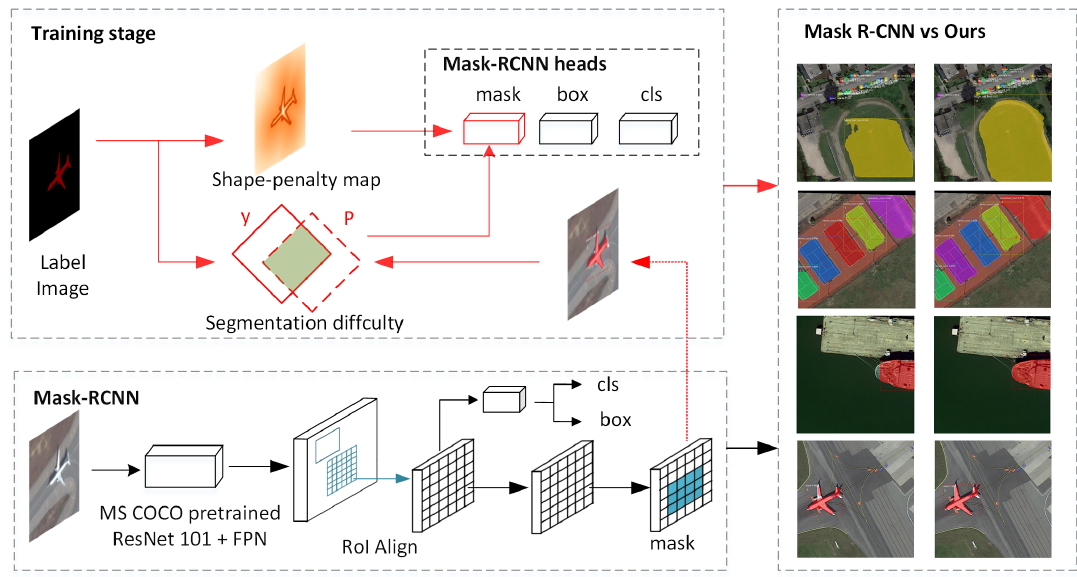
Figure 2. The overall workflow of the proposed method built in Mask R-CNN. There are two main stages of our approach. First, the instance segmentation difficulty that reliably describes the instance segmentation quality is calculated for emphasising hard instances. Then, a shape-penalty map is generated offline to discriminatively strengthen hard edges of different shapes, in which pixels at sharp edges are weighted higher than those at flat edges and in internal areas of the object. Finally, the instance segmentation difficulty and the shape-penalty map are combined and used at the mask head for precise mask prediction. The segmentation results obtained with and without our method are shown on the